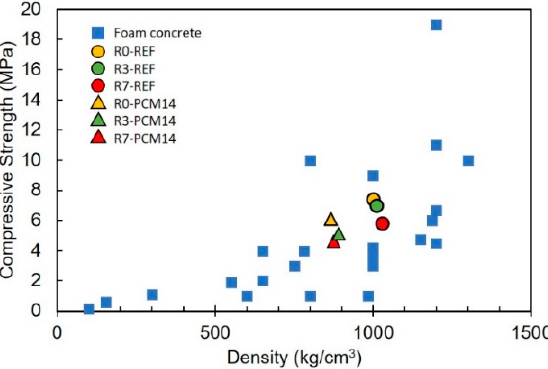
Figure 16. Comparison of the compressive strength of the cellular specimens with normal foam concrete [8,10].